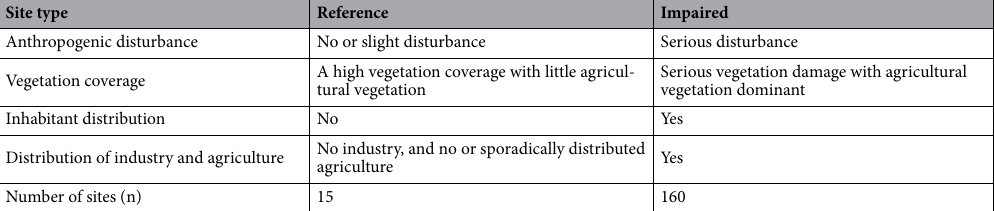
Table 7. Assessment criteria for reference sites and impaired sites and the assessment